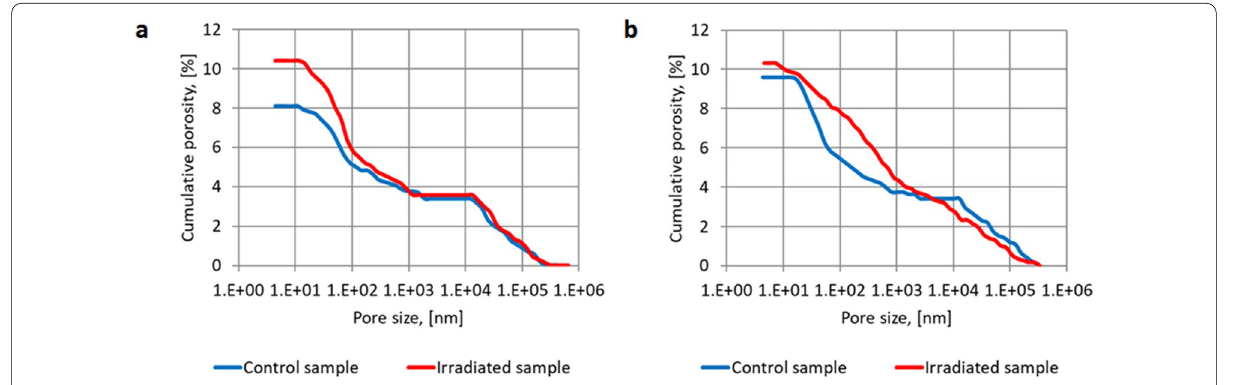
Fig. 13 Cumulative curves of pore size distribution: a not loaded samples, b loaded